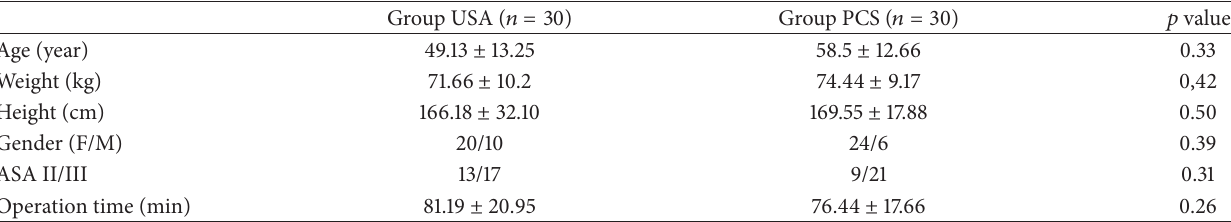
Table 1: Demographic data (mean ± SD).